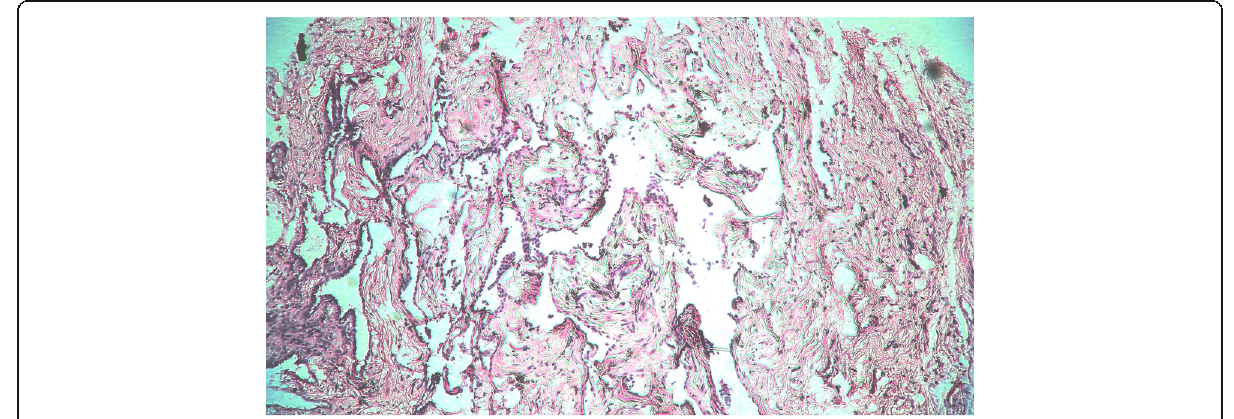
Fig. 3 Microphotograph of pulmonary tissue showing fibrotic stage of diffuse alveolar damage (H&E, X400)